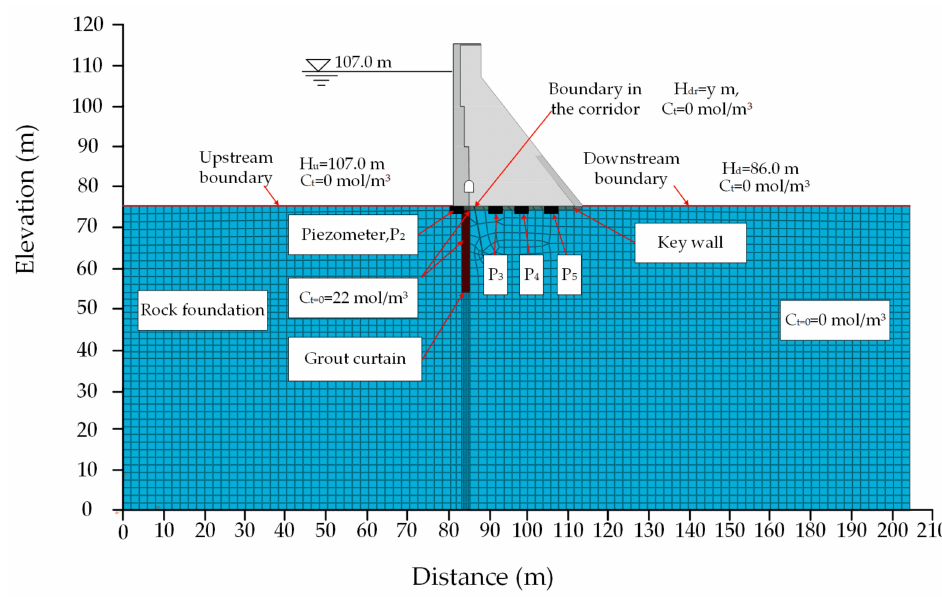
Figure 4. 2D finite element mesh of Shimantan